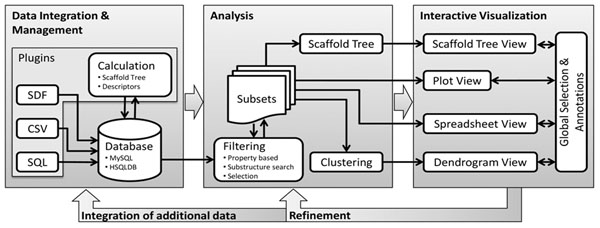
Iterative Workflow.